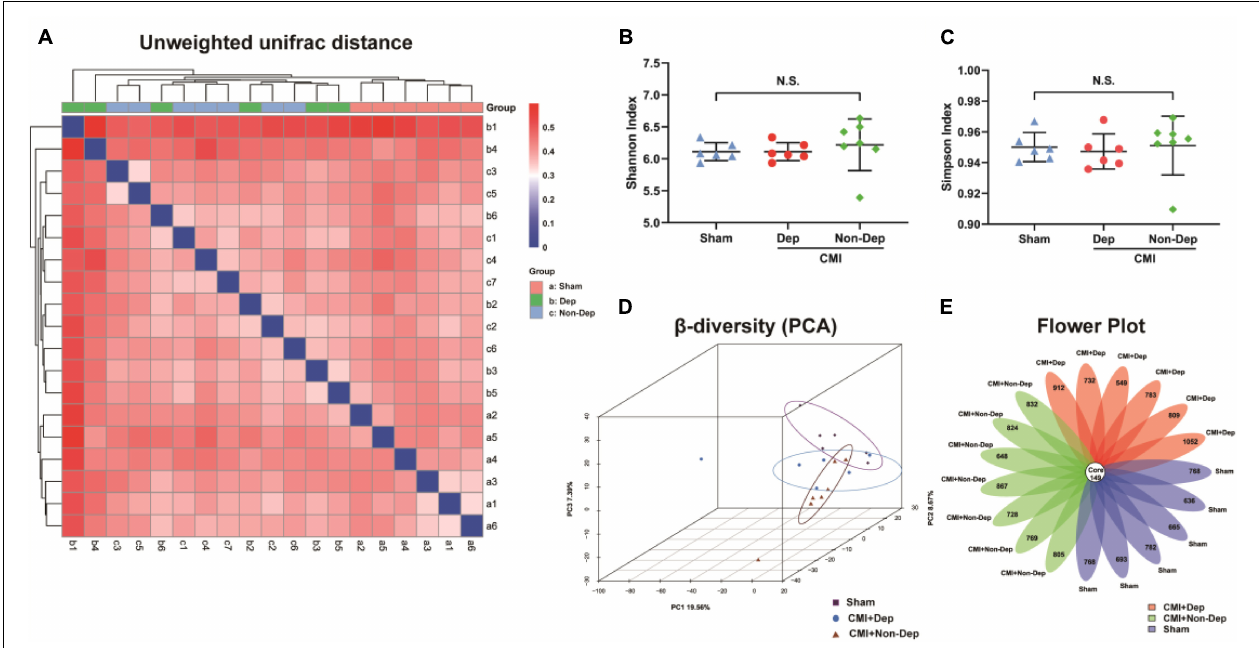
FIGURE 4 | Differences in gut microbiota profiles among Sham, CMI + Dep, and CMI + Non-Dep group rats. (A) Unweighted unifrac diversity distance. (B) Shannon index (one-way ANOVA; F2, 16 = 0.3482, p > 0.05). (C) Simpson index (one-way ANOVA; F2, 16 = 0.1202, p > 0.05). (D) PCA analysis of gut microbiota. (E) Flower plot of OTUs distribution. The numbers in the core represented the OTUs shared by all samples, and the numbers on the petals represented the total OTUs of each sample minus the number of OTUs shared. The α -diversity was shown as mean ± SEM. ( n = 6–7 individual fecal samples/group). N.S., not significant. CMI, chronic myocardial infarction; Dep, depression-like behavior; Non-Dep, non-depression-like behavior; PCA, principal component analysis.